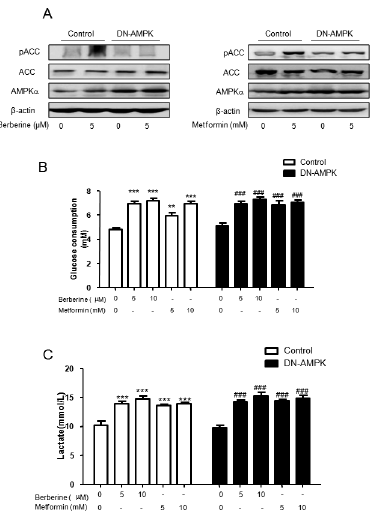
Figure 8. Effects of berberine on glucose consumption and lactate release in DN-AMPK adenovirus infected HepG2 hepatocytes. HepG2 cells were infected with adenoviruses expressing control GFP reporter protein or DN-AMPK for 5–6 h then treated with berberine or metformin for 24h. The protein level was examined using Western blot (A). It had been found that DN-AMPK adenovirus expression reversed berberine- or metformin-induced ACC phosphor- ylation. However, the enhancement of glucose consumption (B) and lactate release (C) stimulated by berberine and metformin was not altered. Results are shown as means 6 SEM from at least three independent experiments; ** P , 0.01, *** P , 0.001, ### P , 0.001 vs . untreated control in corresponding